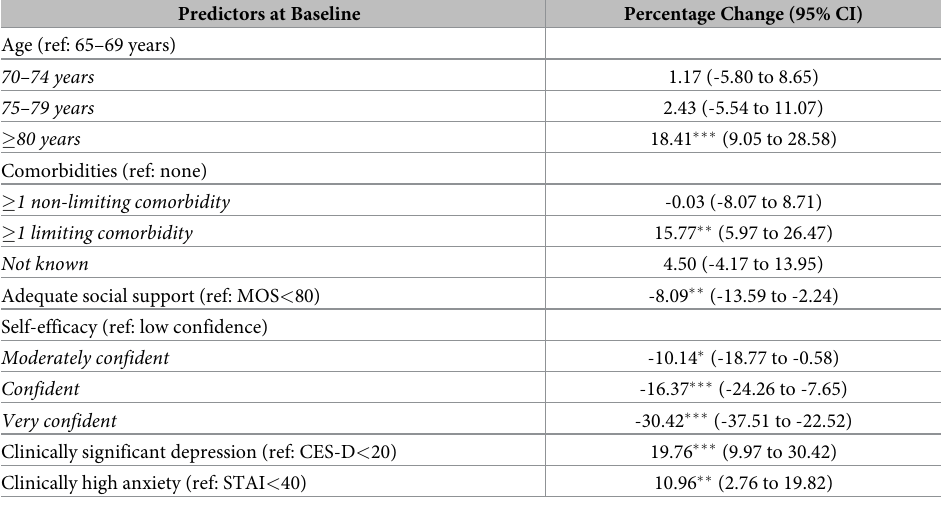
Table 2. Log-linear regression model predicting the QLACS-GSS score over the five-year follow-up post-surgery, predictors collected at baseline (pre-surgery), presented coefficients converted to percentage change and 95% con- fidence intervals